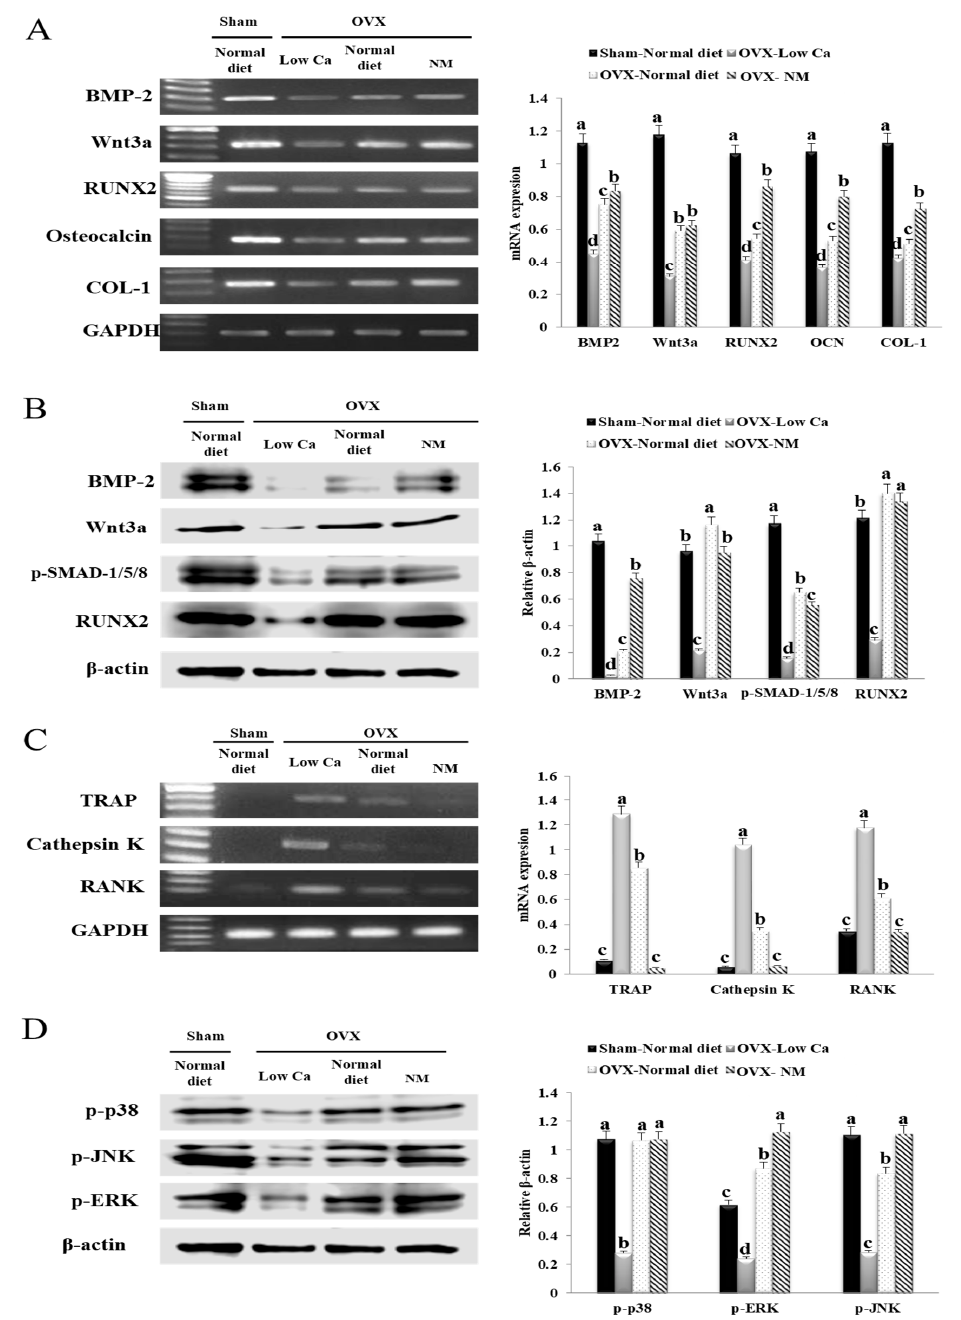
Figure 7. In vivo gene expression and histomorphology of the tibia of ovariectomized (OVX) rats. ( A ) mRNA expression levels of osteoblast di ff erentiation factors: bone morphogenetic protein-2 (BMP-2), Wnt family member 3a (Wnt3a), runt-related transcription factor-2 (RUNX2), osteocalcin, and type-1 collagen (COL-1). ( B ) Protein expression levels of osteoblast di ff erentiation factors: BMP-2, Wnt3a, phosphorylated small mothers against decapentaplegic homolog 1 / 5 / 8 (p-SMAD 1 / 5 / 8), and RUNX2. ( C ) Expression levels of phosphorylated extracellular signal-regulated kinase (p-ERK), p-p38, phosphorylated serine / threonine kinase (p-AKT), and phosphorylated c-Jun N-terminal kinase (p-JNK). ( D ) mRNA expression levels of receptor activator of nuclear factor kappa-B (RANK), tartrate resistant acid phosphatase (TRAP), and cathepsin K in vivo. Each value is expressed as the mean ± SD. Values not sharing a common superscript ( a – d ) di ff ered significantly (Duncan’s multiple range test) ( p <